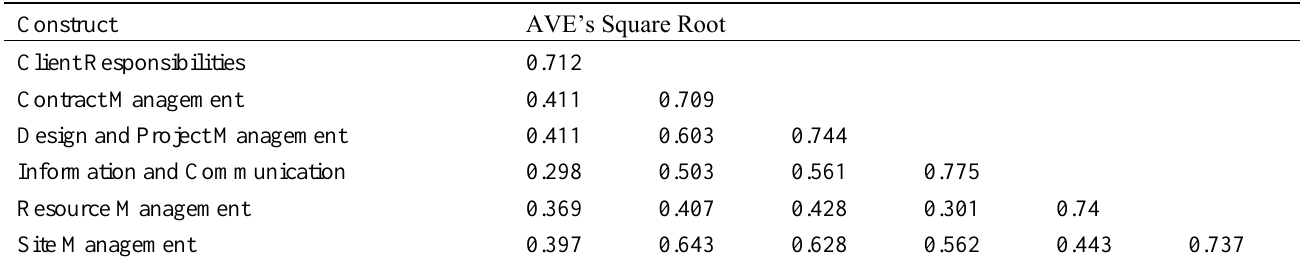
Table 4 Latent variable correlations (Fornell-Larker Criteria) Construct AVE’s Square Root Client